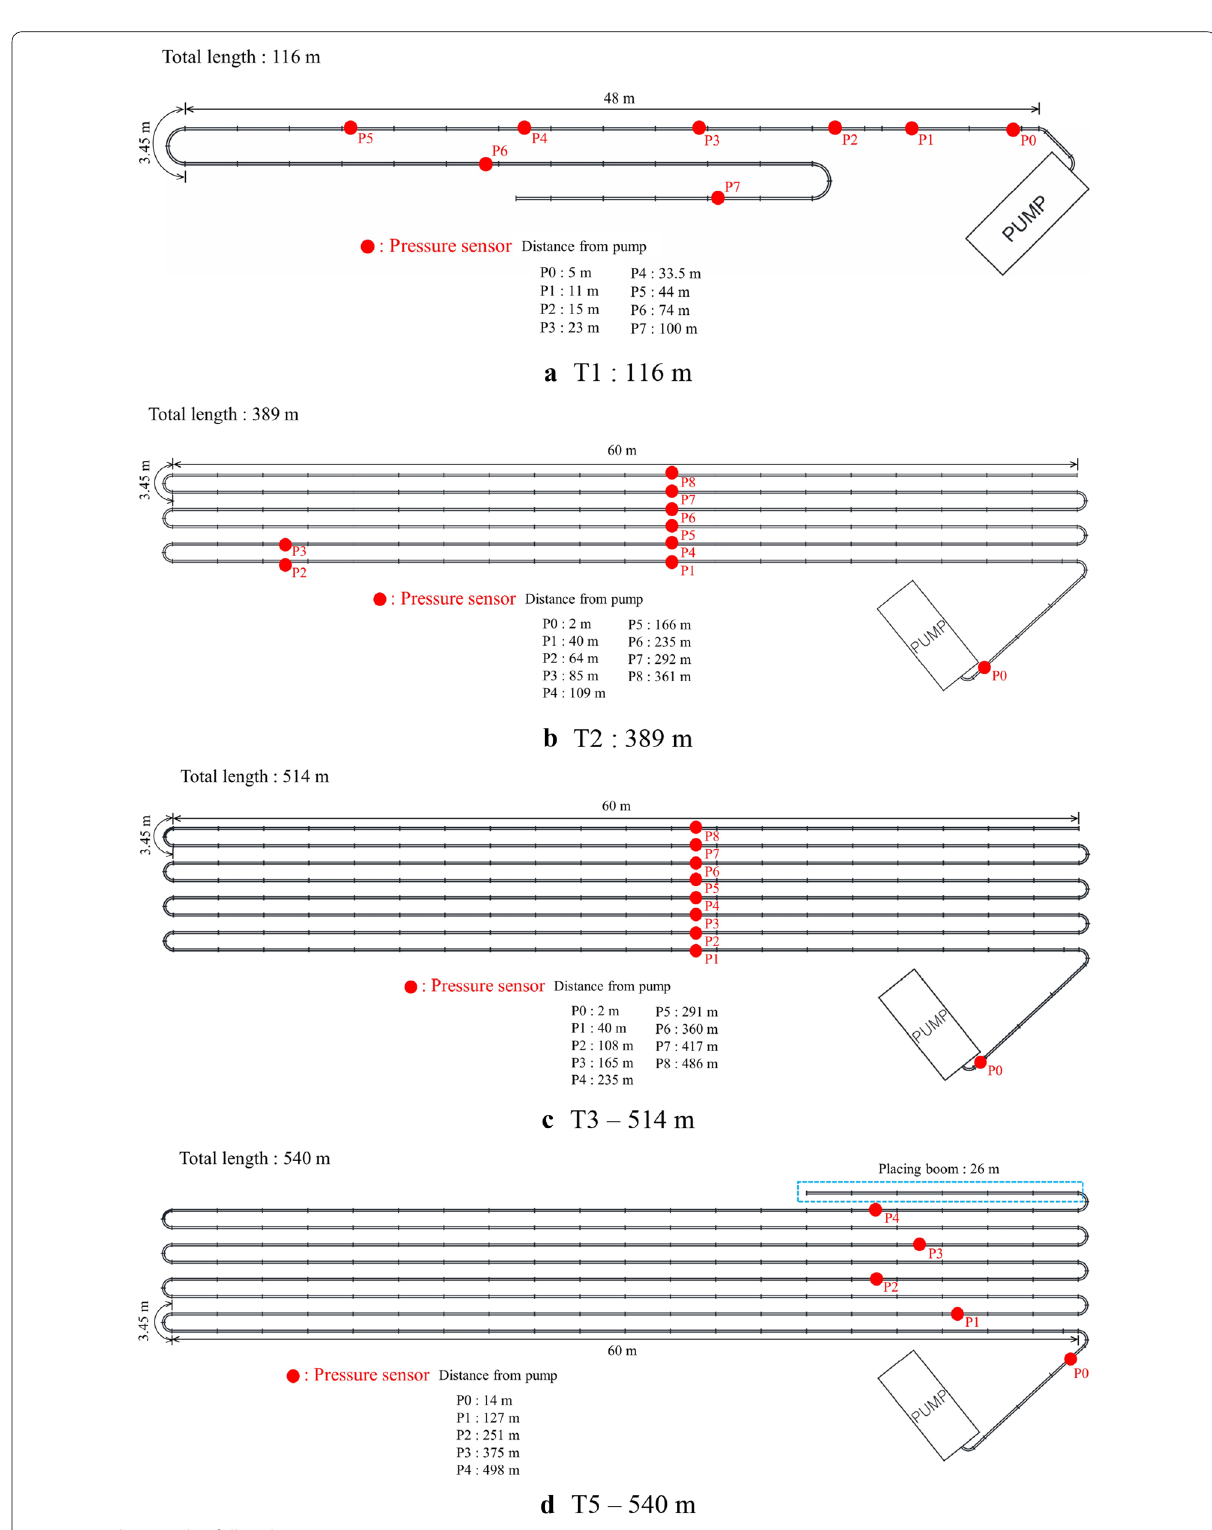
Fig. 1 Pipeline used in full-scale pumping